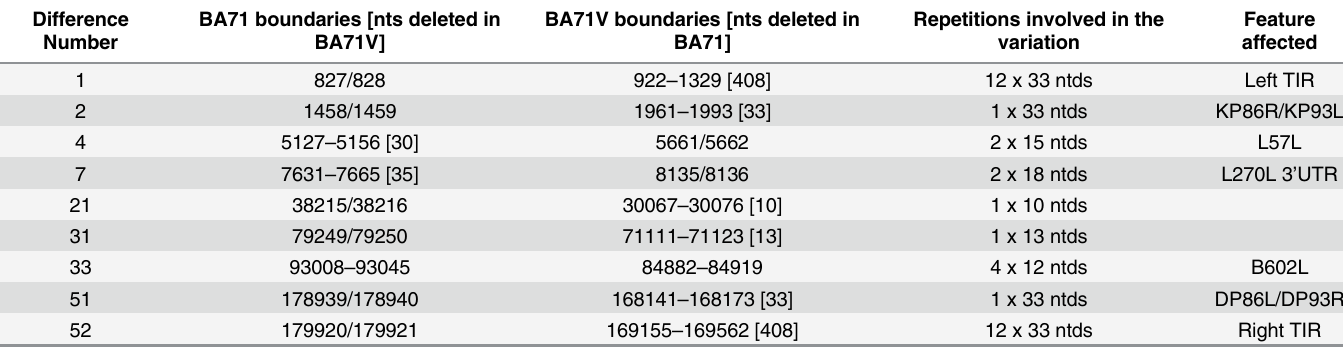
Table 3. Differences between BA71 and BA71V: Variations in the number or in the sequence of tandem repeats.